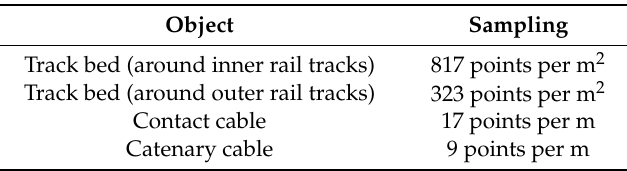
Table 1. Point Sampling on Various Parts of the